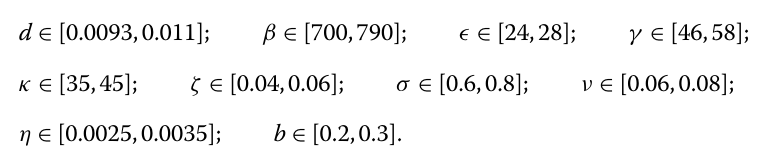
The asymptotic parameter correlation matrix is shown in Table